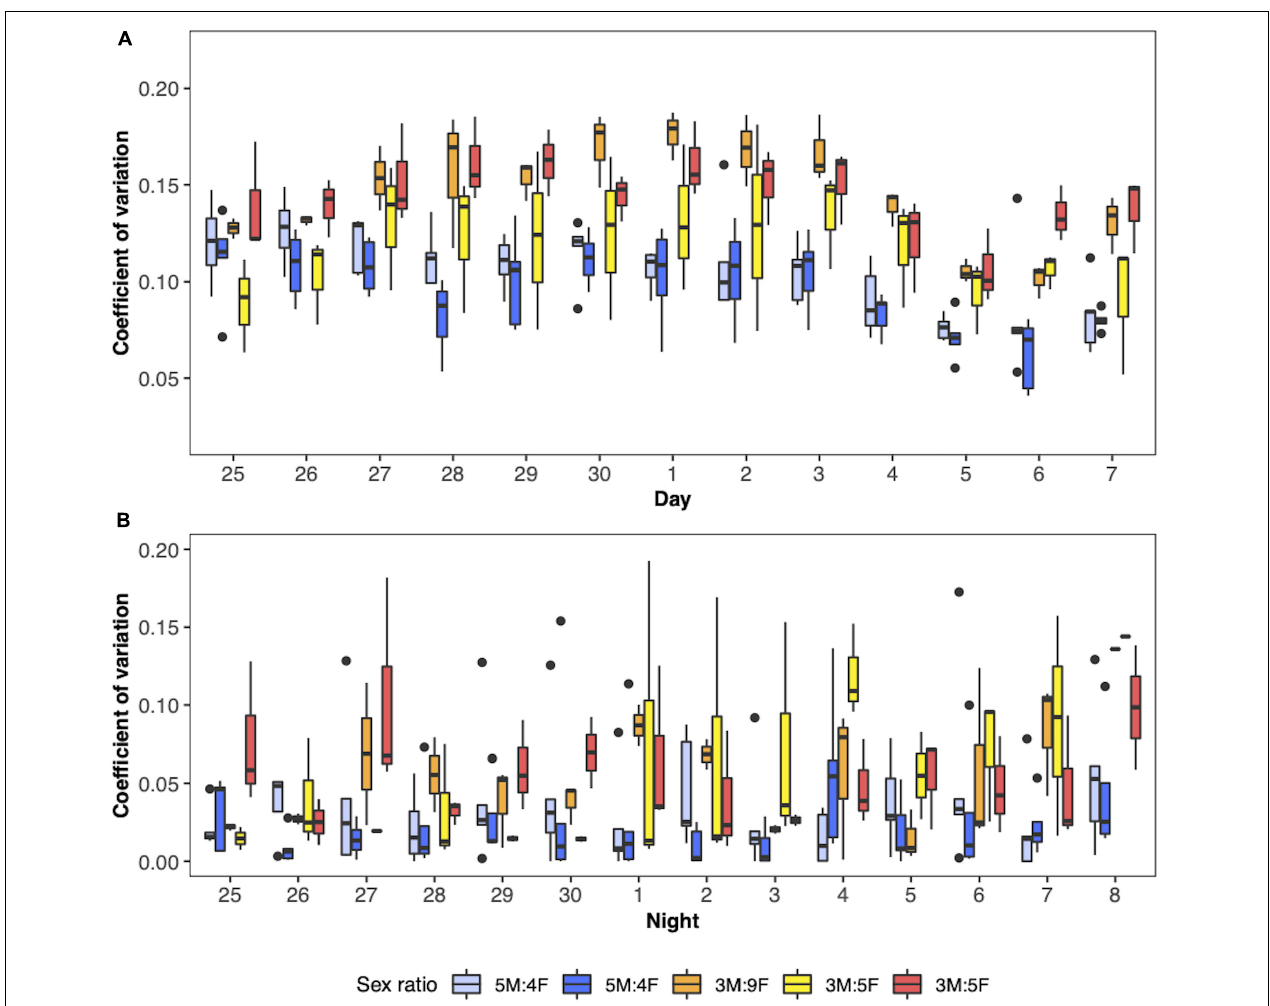
FIGURE 3 | Boxplots showing the activity of male yellow-rumped warblers ( Setophaga coronata coronata ) in the spring. Data for day activity is shown in panel (A) and for the night in panel (B) . Activity is represented as the coefficient of variation where a higher value indicates more movement. The x-axis labels correspond to dates between 25 April and 8 May 2019. Different colors represent the different rooms and the legend outlines the corresponding sex ratio treatment as males: females (M:F). The lower and upper hinges of each boxplot represent the 25th and 95th percentiles, a line is shown at the median value, and individual points fall outside of these